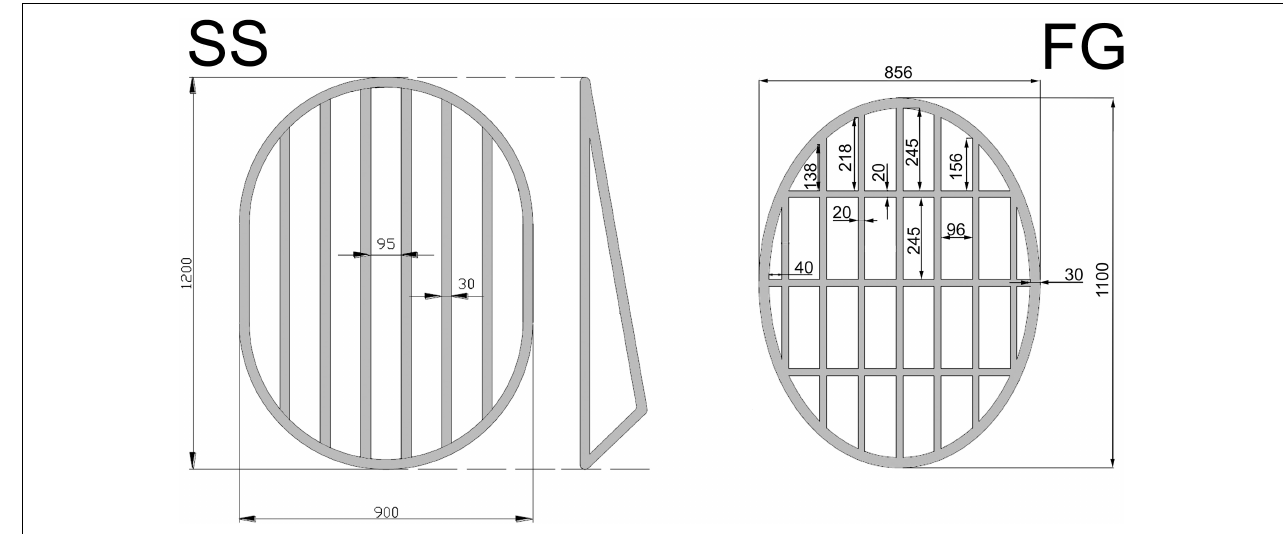
FIGURE 2 | Technical features of the Supershooter (SS) and Flexgrid (FG) TEDs (measurements in